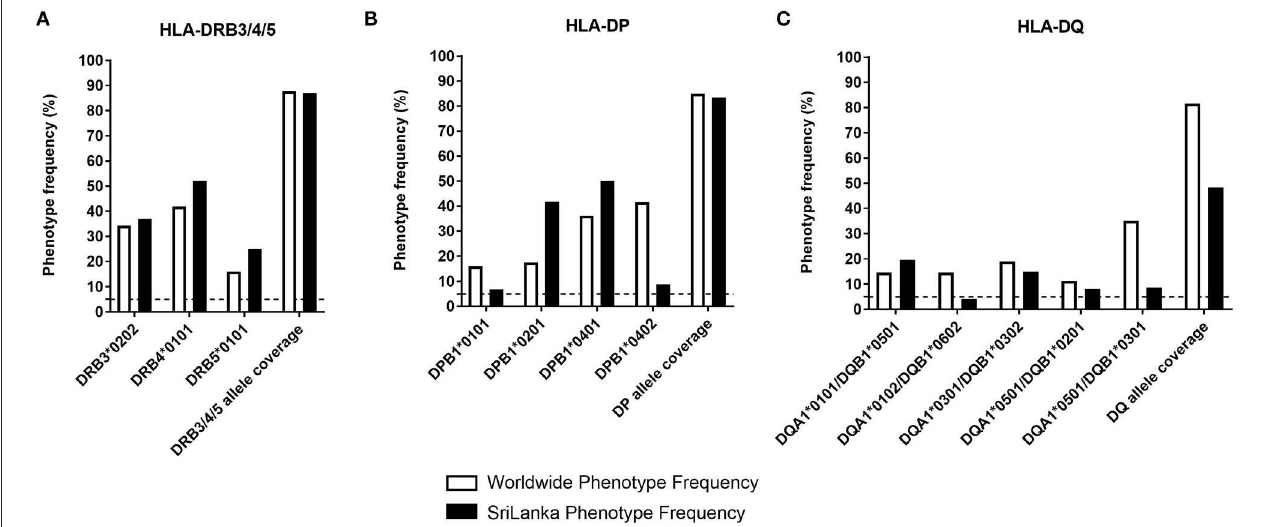
FIGURE 1 | HLA class II phenotype frequencies in DP, DQ, and DRB3/4/5 loci. The HLA-DRB3/4/5 (A) , -DP (B) , and -DQ (C) phenotypic frequency and allele coverage worldwide (white bars), is compared to the one observed in Sri Lanka donors ( n = 714, black bars) and based on previously published data (27).